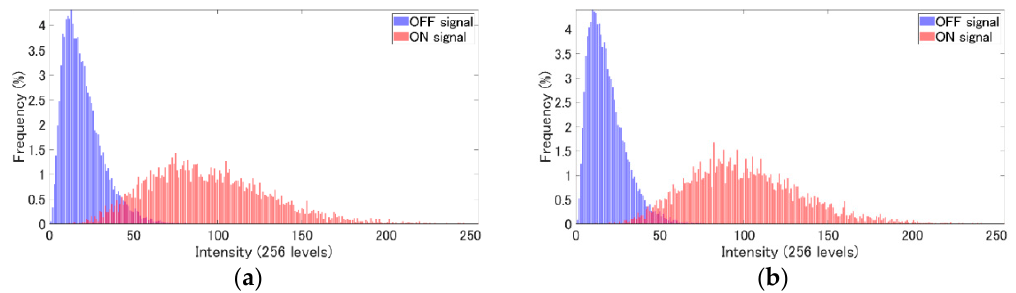
Figure 4. ( a ) Histogram of the reconstructed signal (including unnecessary interference), signal to noise ratio ( SNR ) = 3.8 dB; ( b ) histogram of the reconstructed signal (omitting unnecessary interference), SNR = 5.1 dB.